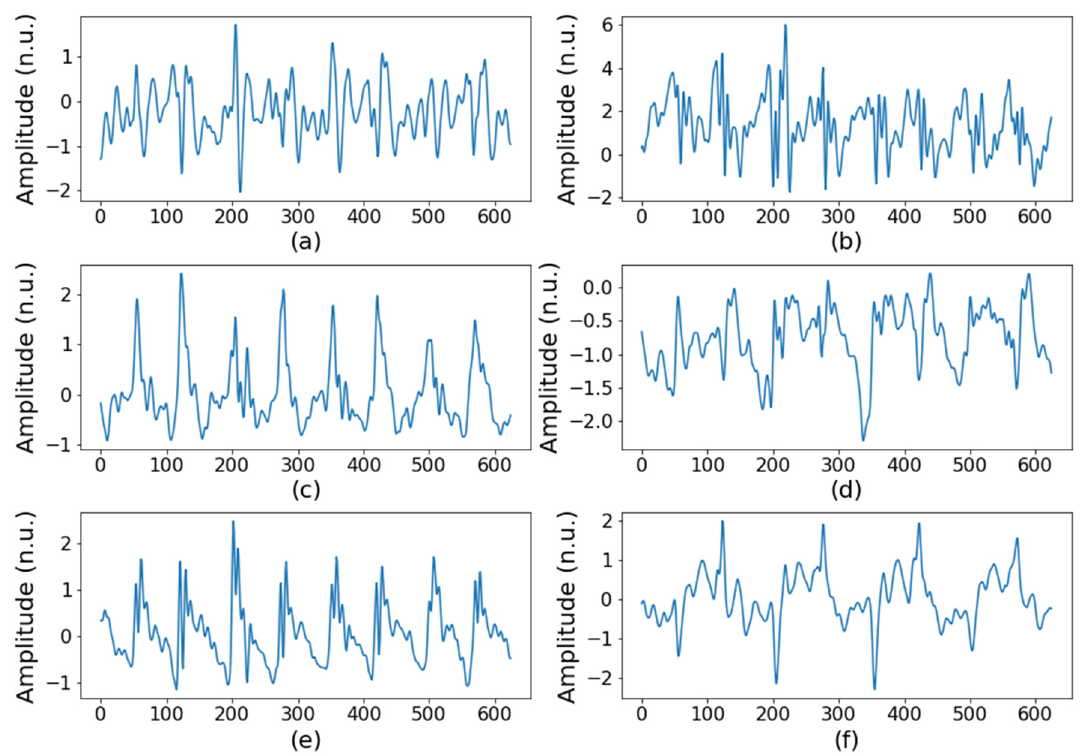
Figure 3. Inertial signals of hemiplegic gait: ( a ) acceleration in the x axis, ( b ) angular velocity in the x axis, ( c ) acceleration in the y axis, ( d ) angular velocity in the y axis, ( e ) acceleration in the z axis, and ( f ) angular velocity in the z axis.